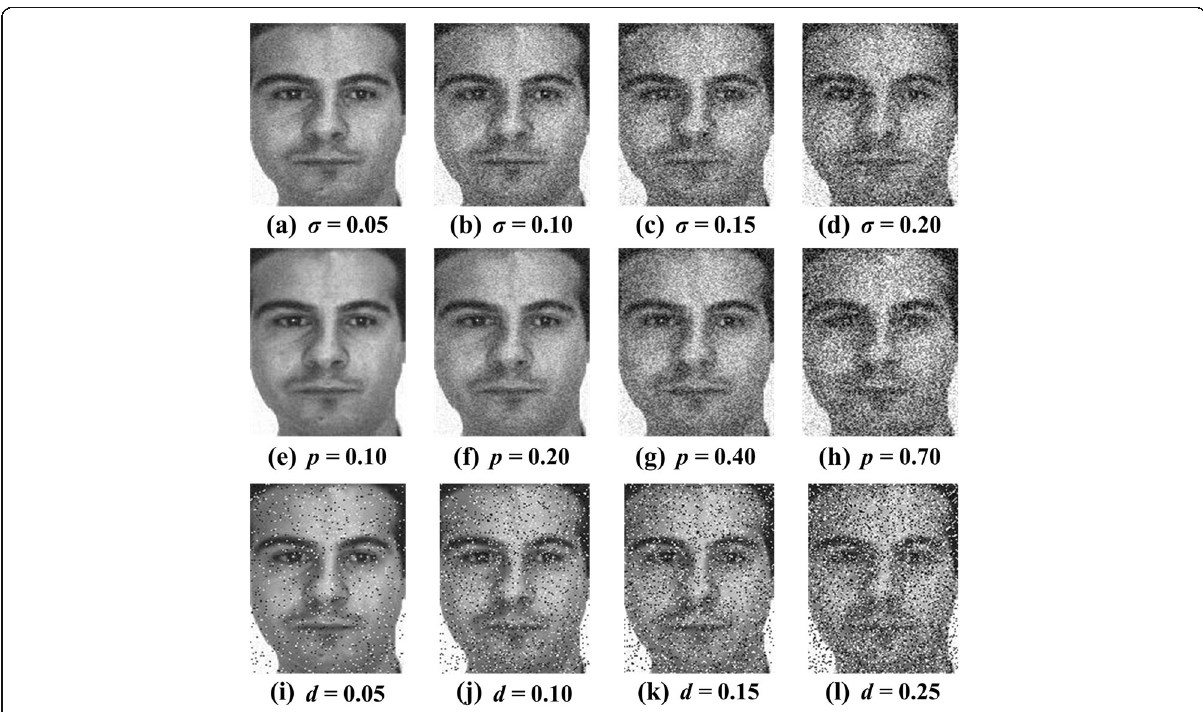
Fig. 4 The sample images of AR database injected with different noise. a – d The first line of Fig. 4 indicates the samples injected with Gaussian noise σ = 0.05, 0.10, 0.15, 0.20. e – h The second line indicates the samples injected with uniform noise p = 0.10, 0.20, 0.40, 0.70. i – l The third line indicates the samples injected with salt and pepper noise d = 0.05, 0.10, 0.15,